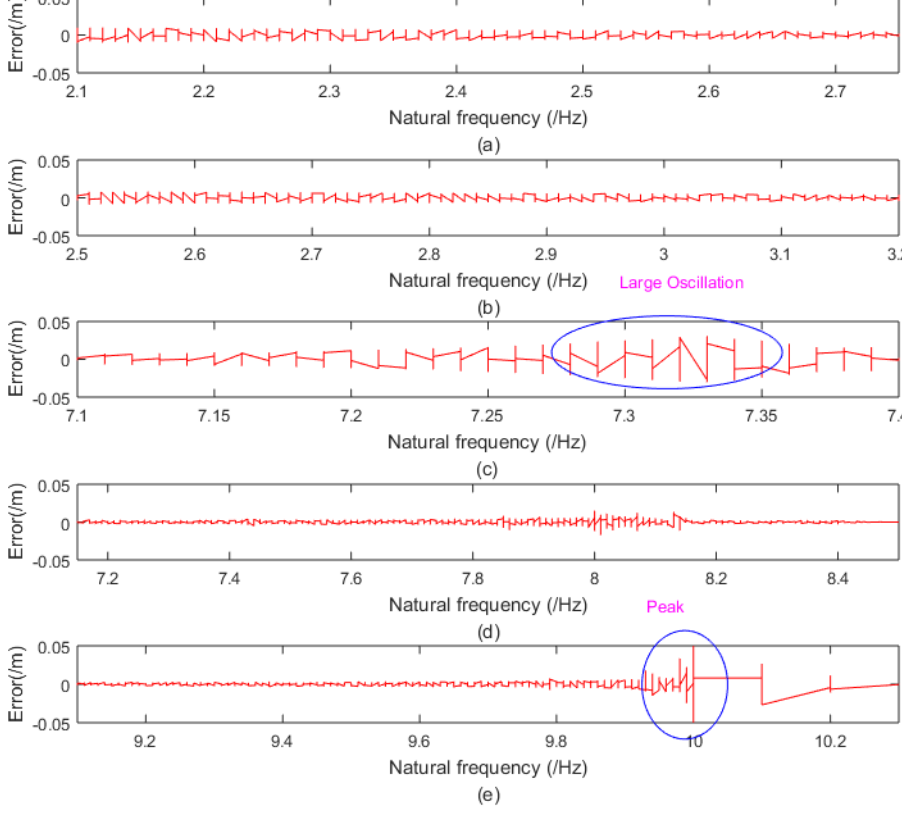
Figure 9. The settlement identifications of the Kriging surrogate model by the inverse function ( a – e ) are the errors of the first five vibration modes, respectively.